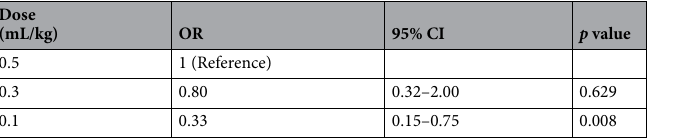
Table 3. Positive results in the V-test for each dose of normal saline. CI, confidence interval; OR, odds ratio; V-test, blood flow velocity test.